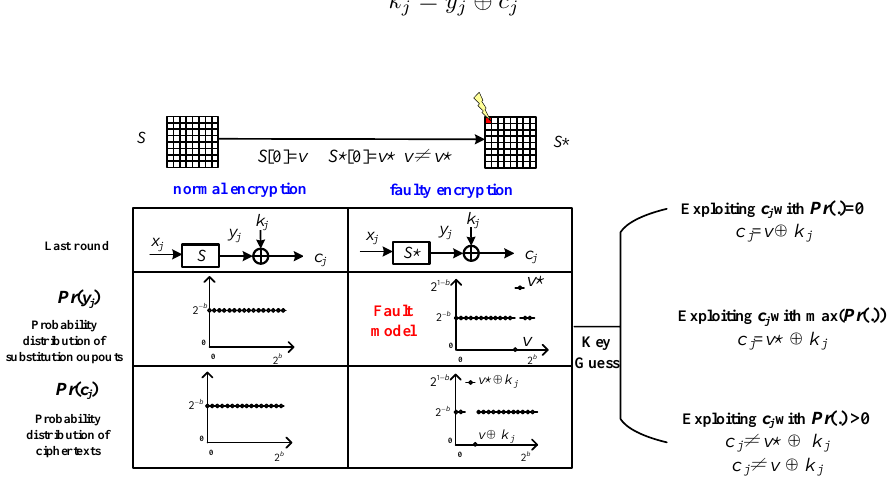
Figure 1: Overview of persistent fault analysis